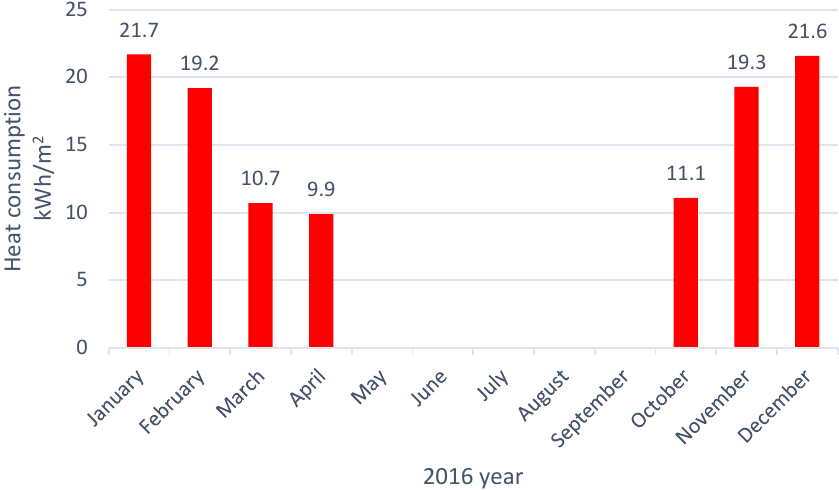
Figure 3. “ D ” building heat consumption for space heating (2016).